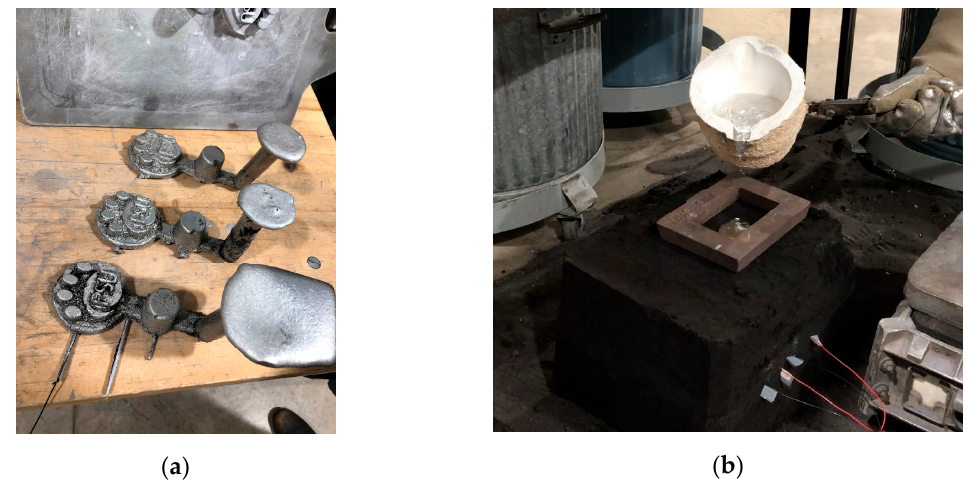
Figure A1. ( a ) Nittany Lion Cast Part showing flashing of metal through the holes made for capacitive sensors; ( b ) Al319 alloy being poured into traditional mold with four sensors inserted from the sidewall.